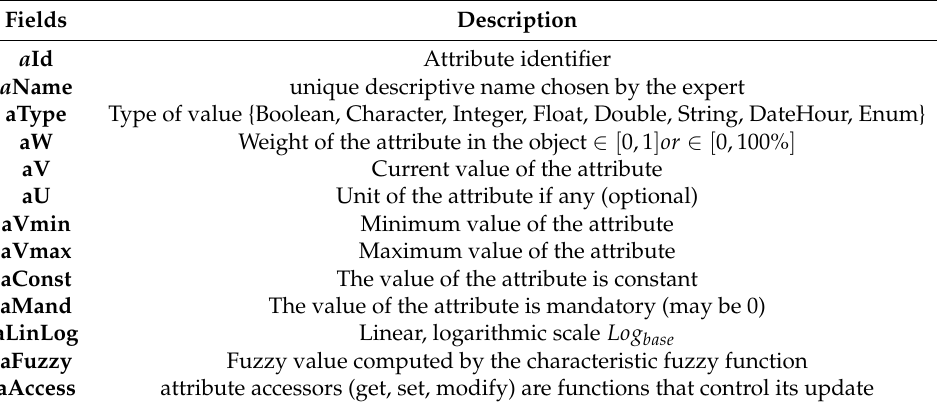
Table 1. Qualifier attribute descriptor.